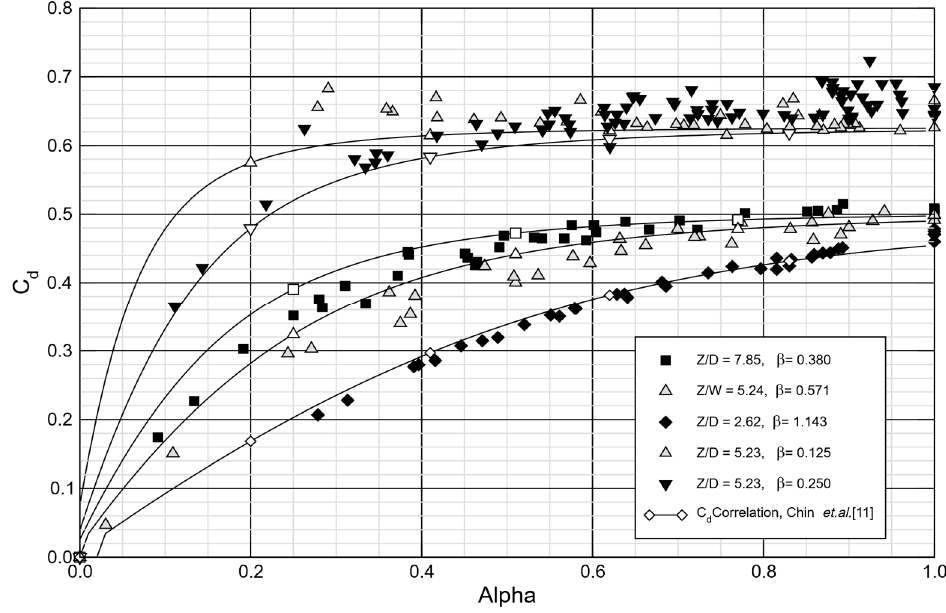
Figure 6. Plain port C d Variation with alpha, experimental data and empirical correlation.